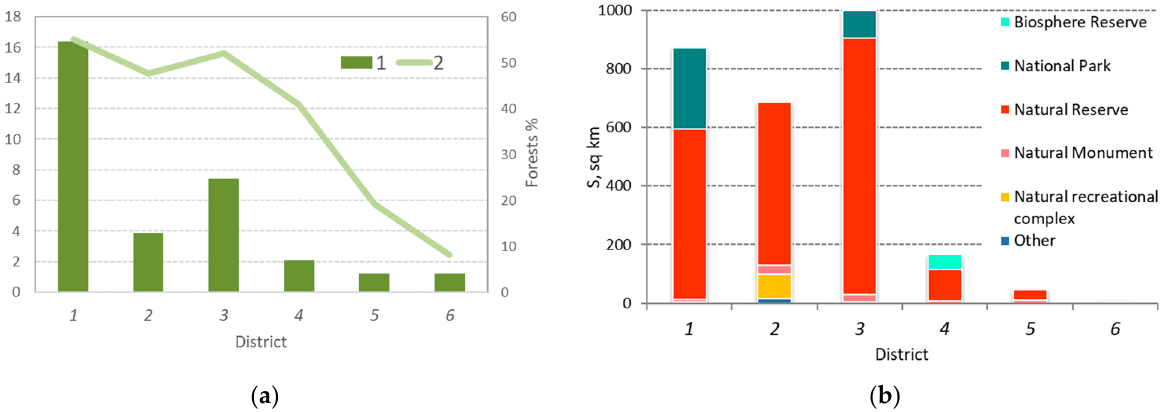
Figure 3. Distribution of PAs in different BDs of the MR: 1—LT, 2—MZ, 3—NSh, 4—PK, 5—KZ, 6—S. ( a )—percentage of PAs (1), forest cover (2); ( b )—distribution of the main categories of PAs by area (km 2 ).